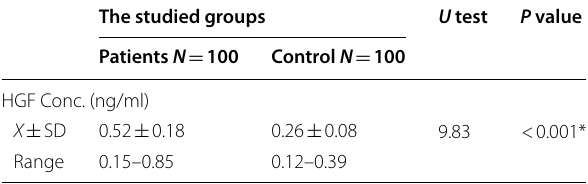
Table 7 HGF concentration in patients and control groups